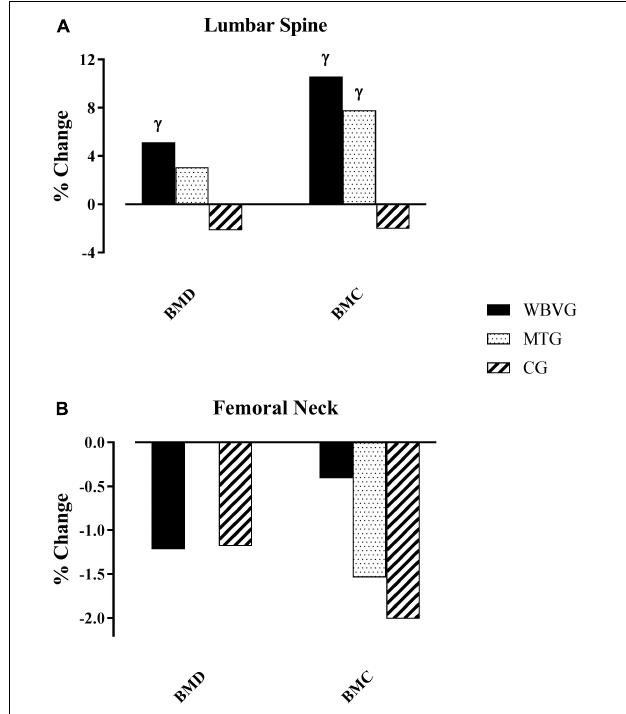
FIGURE 2 | Percentage change in bone parameters. (A) Lumbar spine; (B) femoral neck. γ Clinically relevant changes. WBVG, whole-body vibration group; MTG, multi-component training group; CG, control